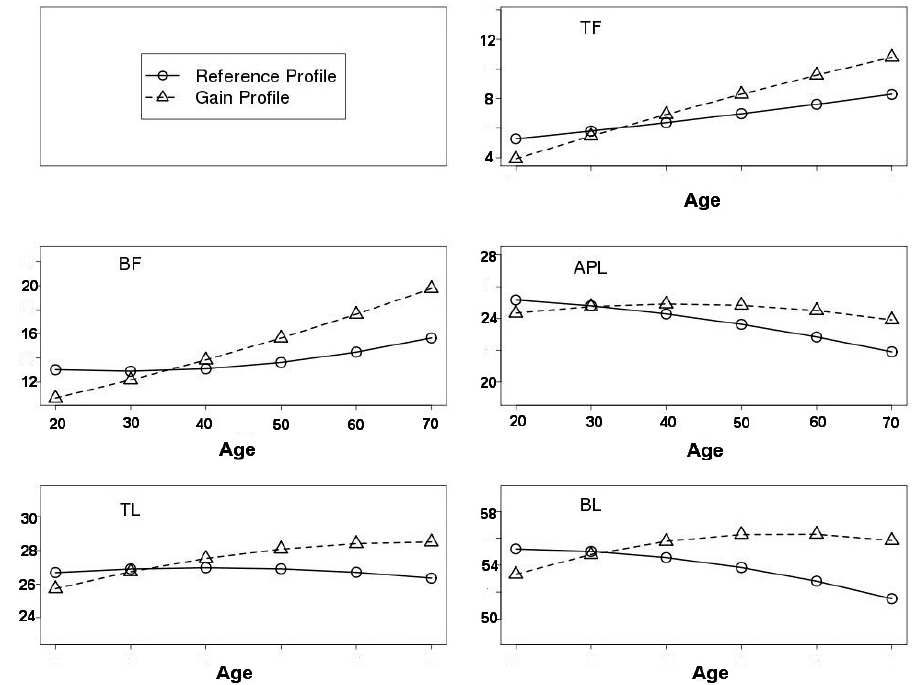
Figure 1. Age-related changes in segmental body composition for NHANES European-American normal men. Age is on the x -axis, and estimates of segmental body compositions from M 11 B , E ( A ) are on the y -axis. Reference profile is represented by (o) and gain profile by ( ∆ ).